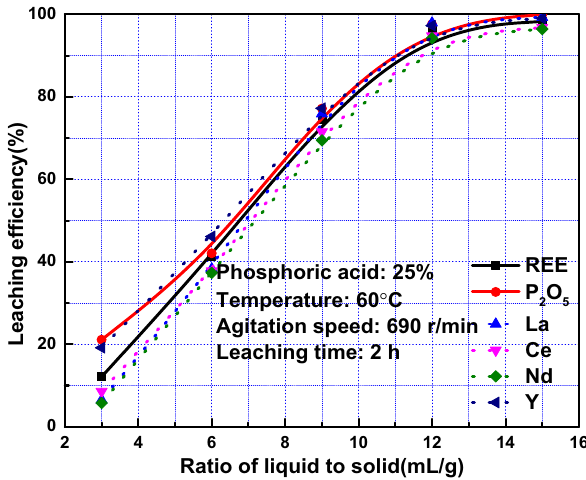
Figure 4: Leaching e ffi ciencies as a function of ratio of liquid to solid.